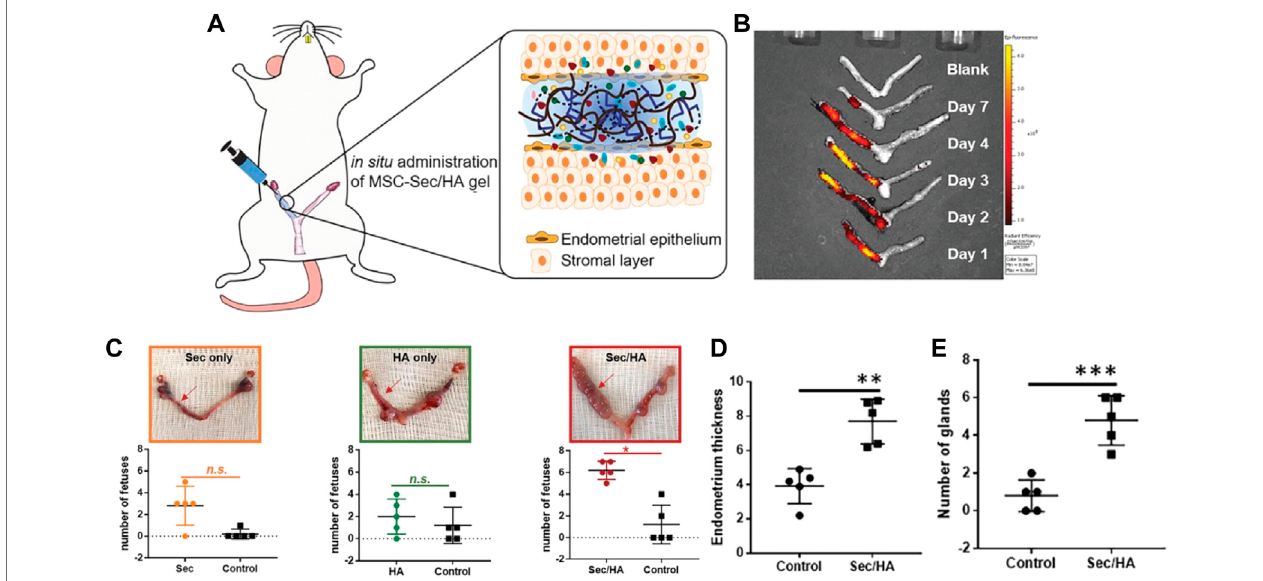
FIGURE 1 | MSC-Sec/HA gel injection and a rodent model of endometrium injury (A) Schematic showing intrauterine injection of MSC-Sec/HA gel. (B) Ex vivo fl uorescent imagingofratuteriat days1,2,3,4,and 7afterinjection. (C) Representativeuterusimagesand quantitative datacomparingthenumbers offetusesonboth sides (red arrow indicates treated side). * indicates p < 0.05 when compared to the other side. (D) Comparison of endometrium thickness between the control side and the treated side of MSC-Sec/HA group. (E) Comparison of number of glands between the control side and the treated side of MSC-Sec/HA group. n = 5, ** indicates p < 0.01,***indicates p < 0.001whencomparedtotheothergroup.Reproducedwithpermissionfromref(Liuetal.,2019).Copyright2019WILEY-VCHVerlag GmbH & Co. KGaA,